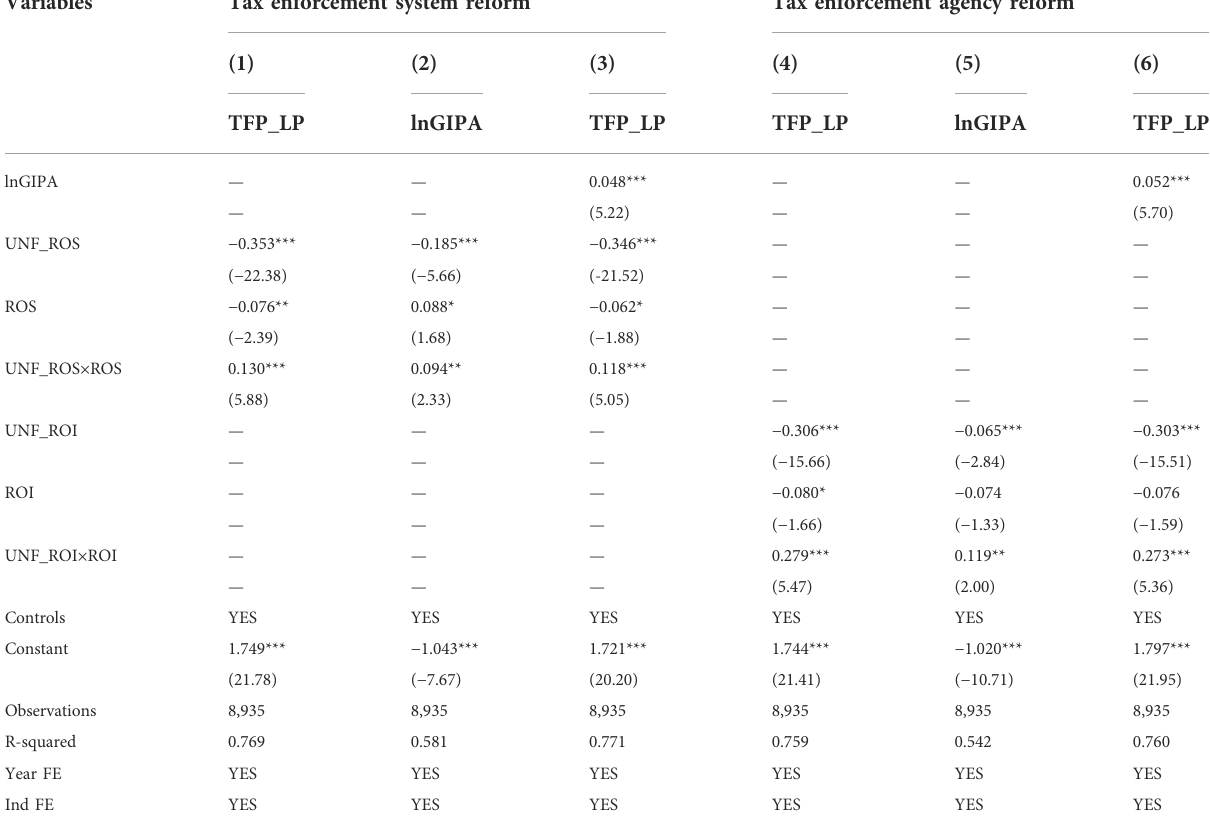
TABLE 9 Mediating mechanism of green invention patent